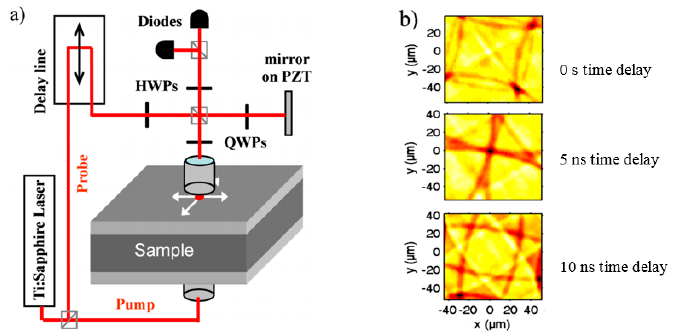
Figure 18. Imaging of a thin film sample using ultrafast optical laser ultrasonics: ( a ) experimental setup and ( b ) surface displacement measurements at three different pump-probe time delays. Changing the time delay between pump and probe (0 ns, 5 ns and 10 ns) provides set of measurements without ultrafast photodetector [123].